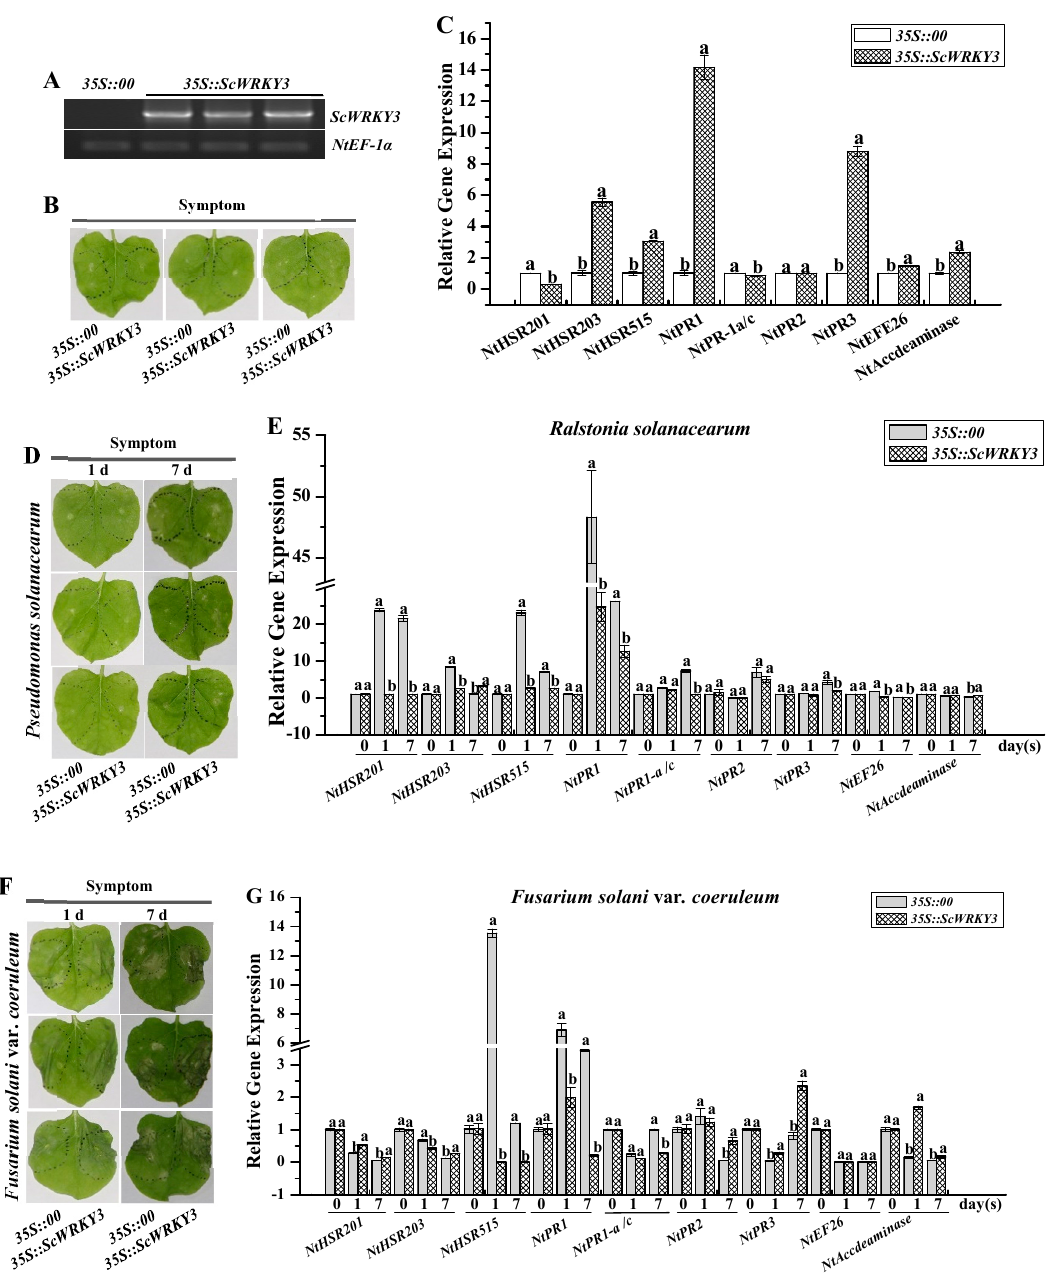
Figure 8. Effects of transient overexpression of ScWRKY3 in Nicotiana benthamiana leaves. ( A ) Semi-quantitative PCR analysis of ScWRKY3 in N. benthamiana leaves after one day of infiltration by Agrobacterium strain GV3101 carrying pEarleyGate 203- ScWRKY3 ( 35S::ScWRKY3 ) and the empty vector pEarleyGate 203 ( 35S::00 ). ( B ) Phenotype of N. benthamiana leaves after one day of agroinfiltration. ( C ) The transcript level of nine immunity-associated marker genes in the N. benthamiana leaves after one day of agroinfiltration. ( D , F ) Disease symptoms of N. benthamiana post-inoculation with Ralstonia solanacearum and Fusarium solani var. coeruleum are observed after one day and seven days of agroinfiltration. ( E , G ) The transcripts of nine immunity-associated marker genes in the N. benthamiana leaves after inoculation with R. solanacearum or F. solani var. coeruleum for one day and seven days. Data are normalized to the NtEF-1 α expression level. All data points are means ± standard error ( n = 3 ). Bars superscripted by different lowercase letters indicate significant differences, as determined by Duncan’s new multiple range test ( p value < 0.05).